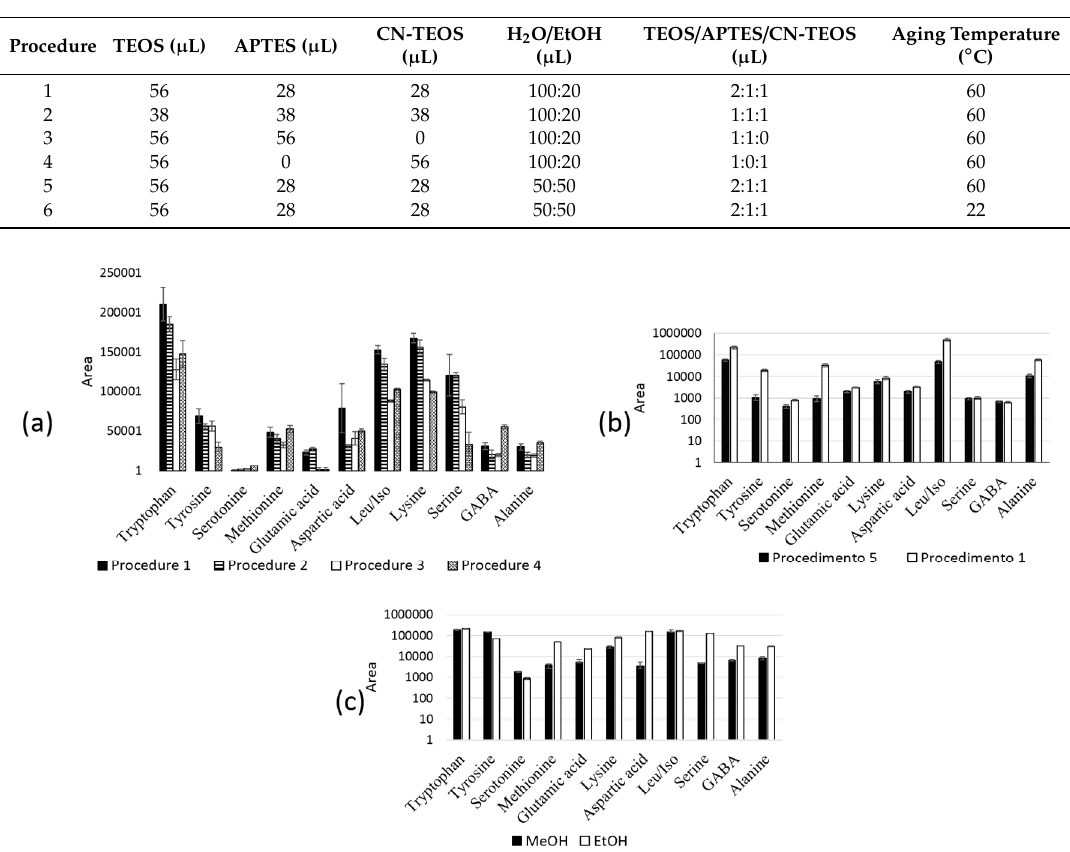
Table 1. Optimization of the synthesis parameters.